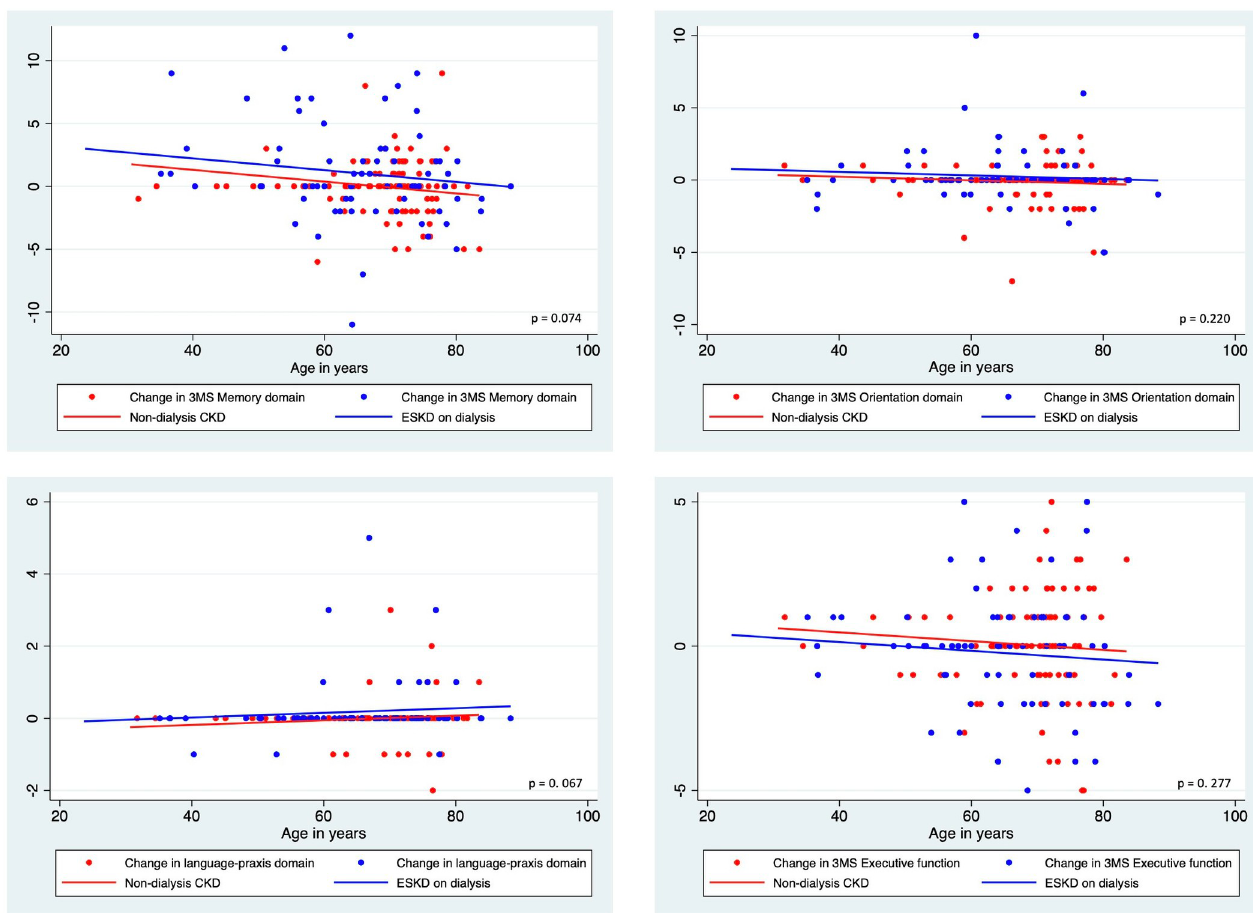
Fig 3. Change scores of memory, orientation, praxis and executive function domains of cognitive function in CKD and ESKD patients with fitted regression lines from ANCOVA models using age as a continuous covariate.